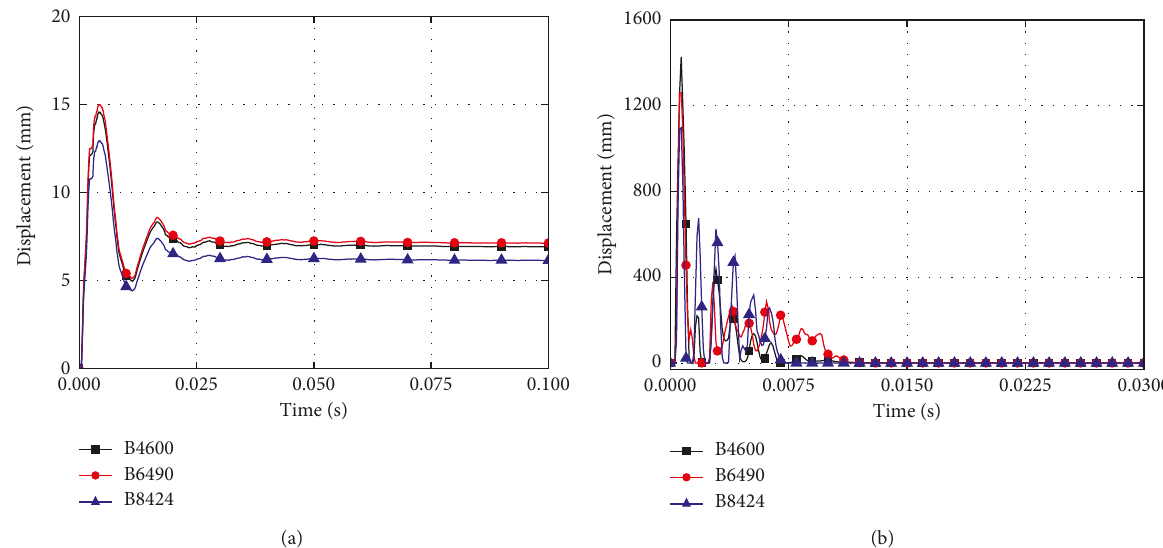
Figure 17: Comparison of impact response (constant kinetic energy). (a) Comparison of midspan displacement. (b) Comparison of impact